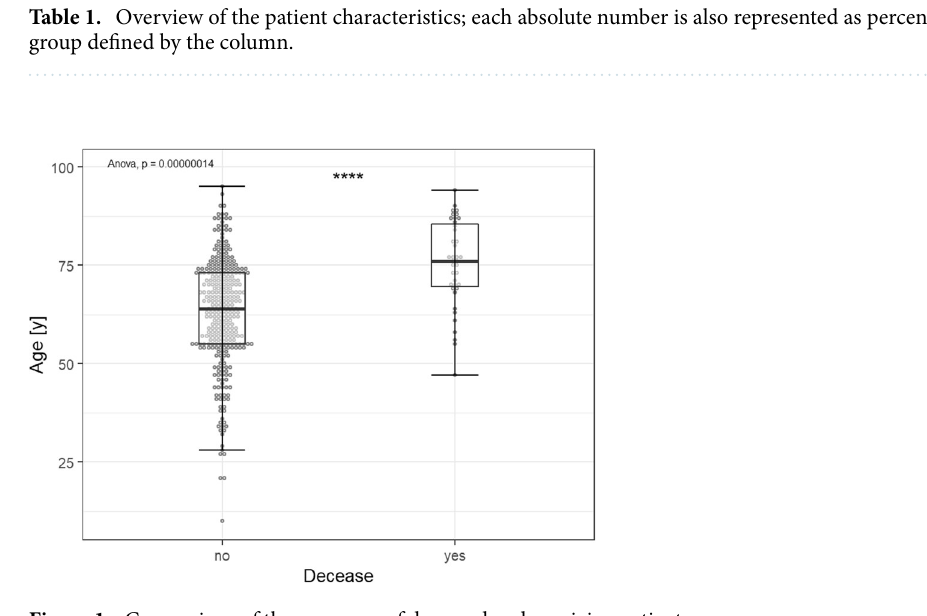
Figure 1. Comparison of the mean age of deceased and surviving